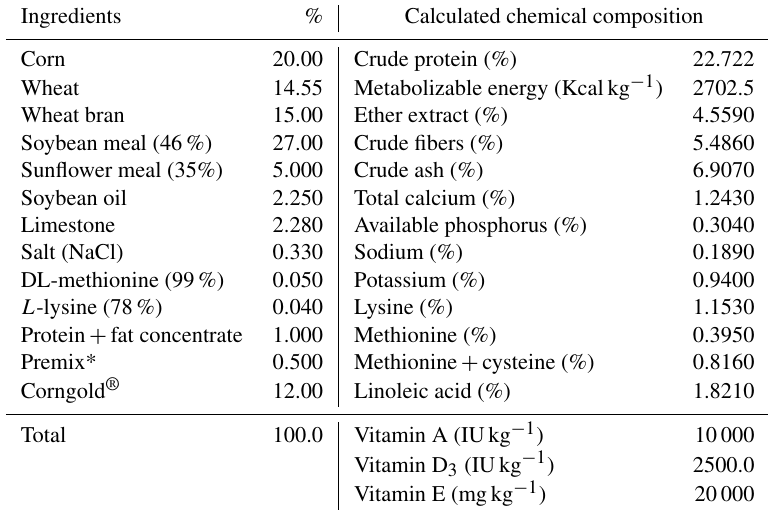
Table 2. Ingredients composition (%) and nutrient calculation of diet in the experiment. Ingredients % Calculated chemical composition Corn 20.00 Crude protein (%) Wheat 14.55 Metabolizable energy (Kcalkg − 1 ) Wheat bran 15.00 Soybean meal (46%) 27.00 Sunflower meal